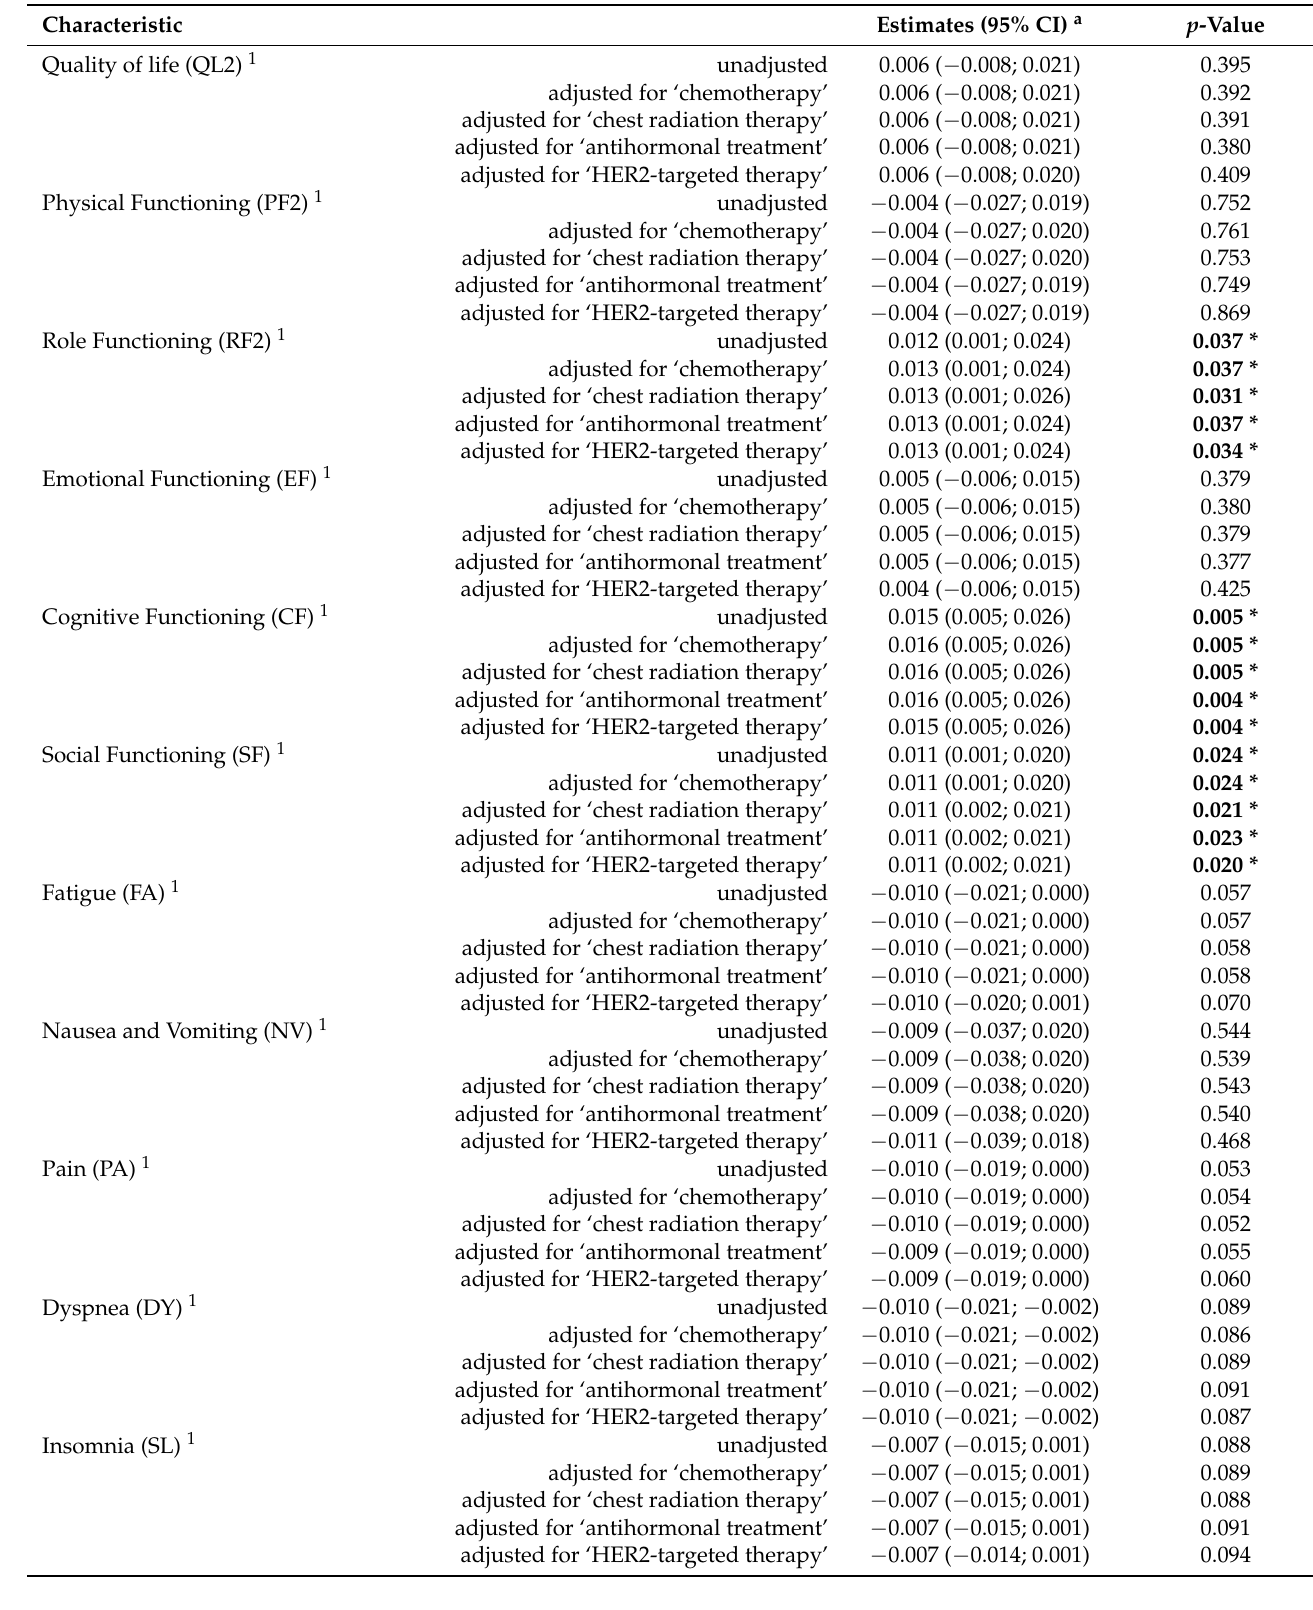
Table A2. Associations between DII and EORTC-QC30 scores adjusted for different types of can- cer